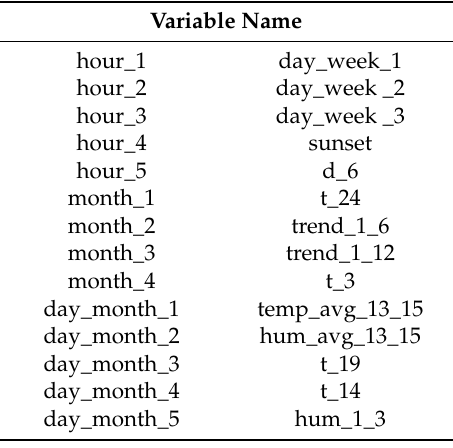
Table 6. Final set of independent variables for forecasting